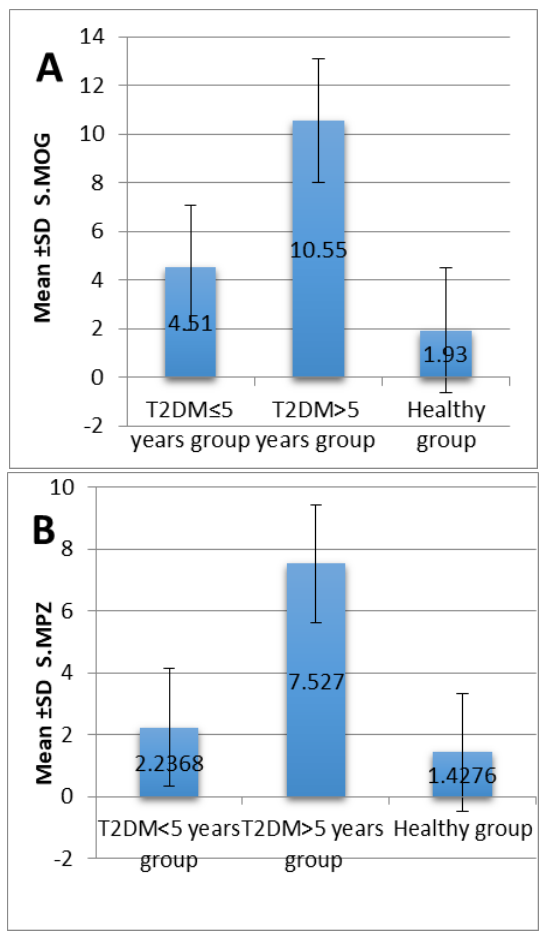
Figure 2 : levels of Mean ± Standard deviation (SD) in MPZ and MOG in the study groups: Levels of A) MOG, B) MPZ, in control and diabetic patient groups